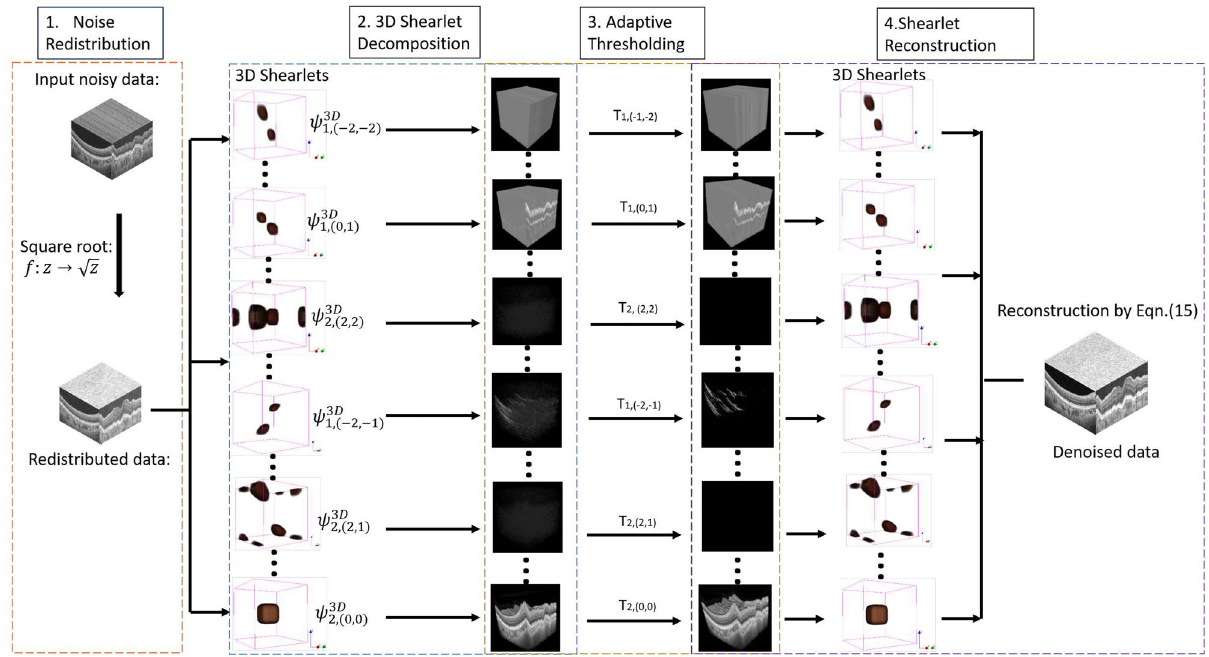
Figure 1. The flowchart of our proposed adaptive-SIN algorithm. In the algorithm, the noise in OCT images are redistributed, and then the redistributed images are decomposed by 3D shearlet transformation, adaptively thresholded to remove the noise and finally reconstructed to obtain the high-quality OCT